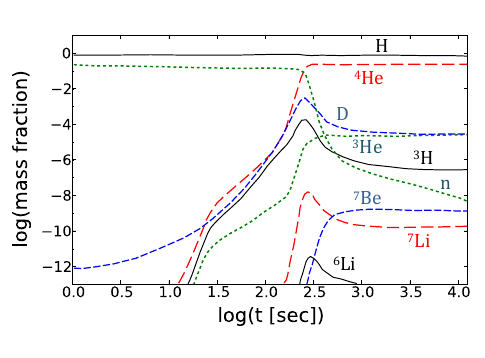
Figure 2: Mass (for 4 He) and number (for other elements) fractions of nuclei in the universe as a function of time.